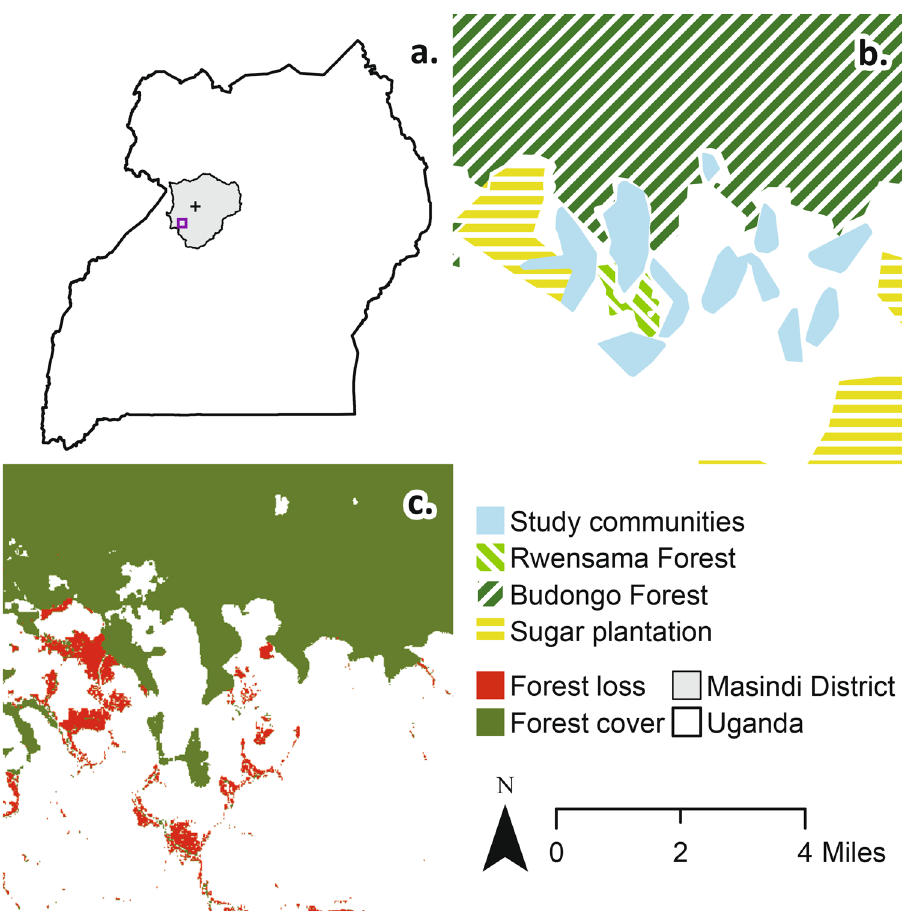
Figure 3. Maps describing the study area. Panel a. describes the location of the study site (purple box) in relation to Masindi Town (‘+’) within Masindi District, Uganda. Panel b. describes the study area, including the 11 study communities, the Budongo and Rwensama Forest Reserves, and the indicative location of large-scale intensive sugarcane estates (adapted from 35,47 ). Panel c. describes forest loss between 2000 and 2016 and forest cover (> 75% tree cover) in 2016 (adapted from 48 ).